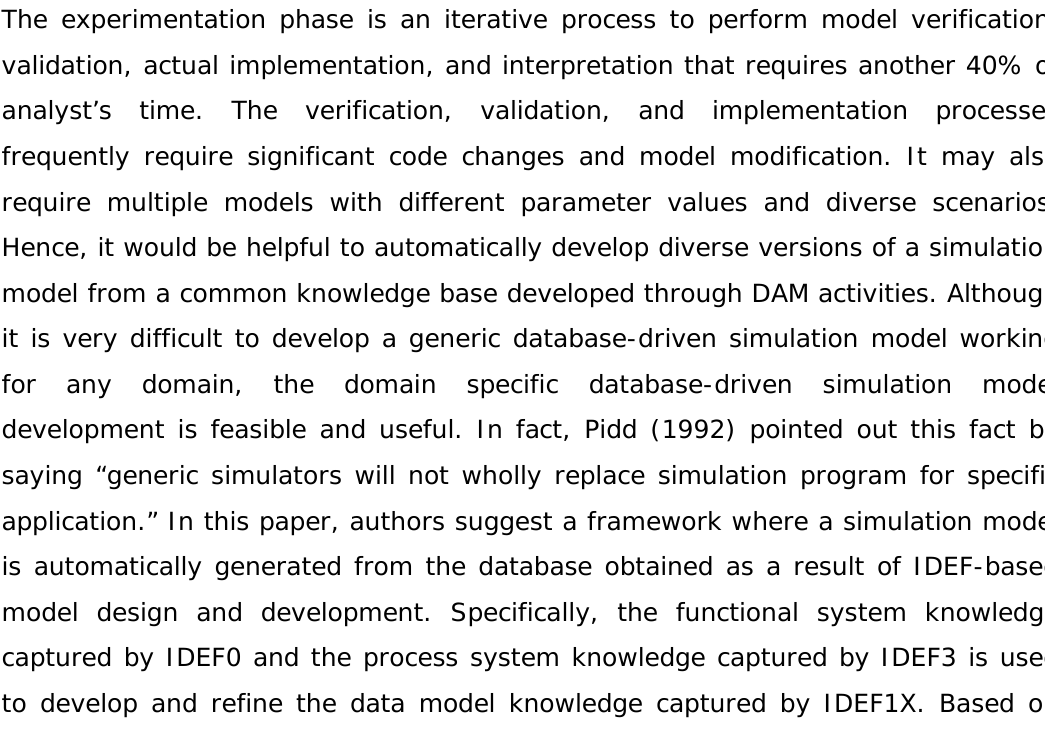
Figure 1. “Conceptual framework of IDEF-based integrated